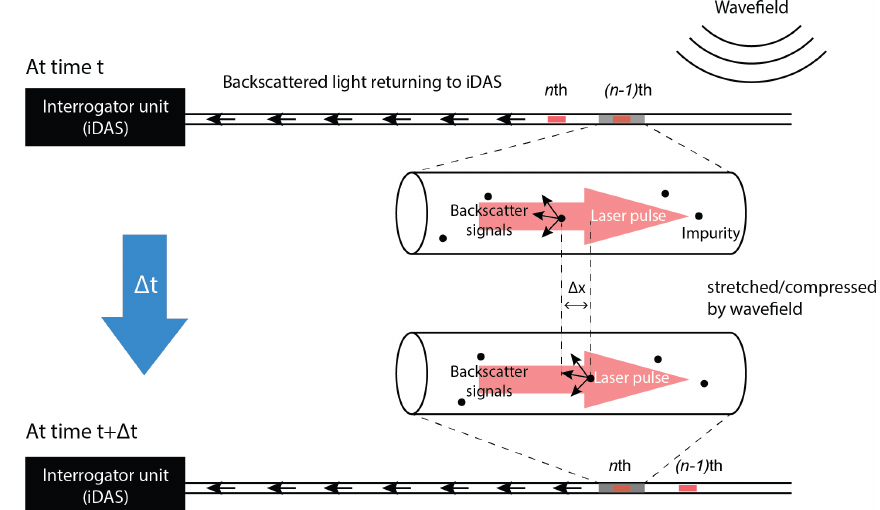
Figure 2. Principle of DAS. Rayleigh backscattering occurs at anomalies in the optical fiber which can be shifted by the surrounding wavefield. The phase changes of successive pulses are recorded by the iDAS